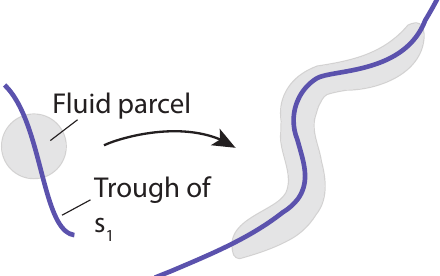
Figure 2. Schematic of the effect of a trough of the attraction rate, s 1 , field on a fluid parcel.